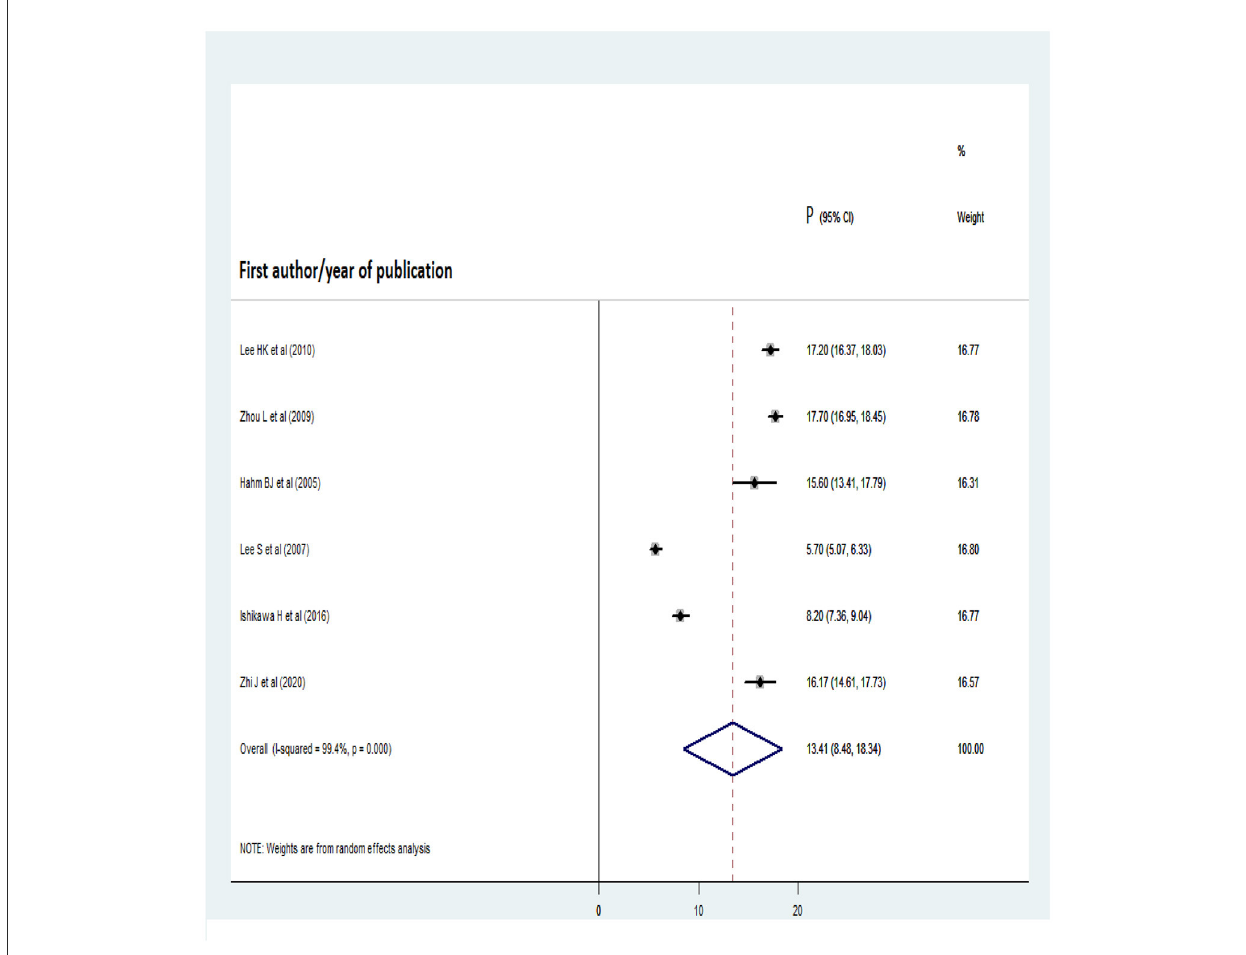
FIGURE5 Forest plot for lifetime pooled prevalence of